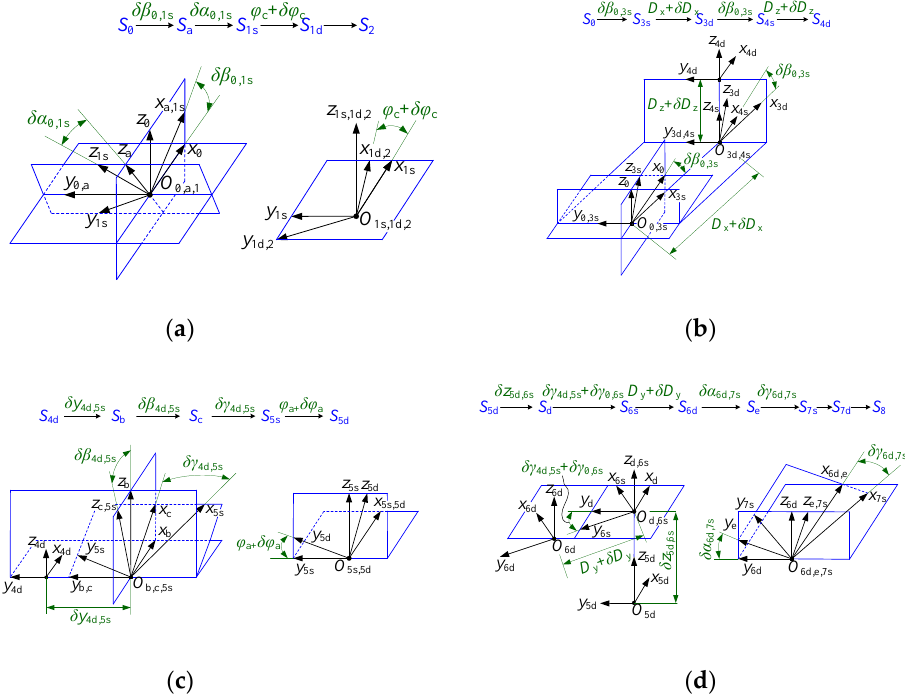
Figure 3. Assembly errors and coordinate systems of the gear grinding system: ( a ) coordinate system S 0 to coordinate system S 2 , ( b ) coordinate system S 0 to coordinate system S 4d , ( c ) coordinate system S 4d to coordinate system S 5d , and ( d ) coordinate system S 5d to coordinate system S 8 .